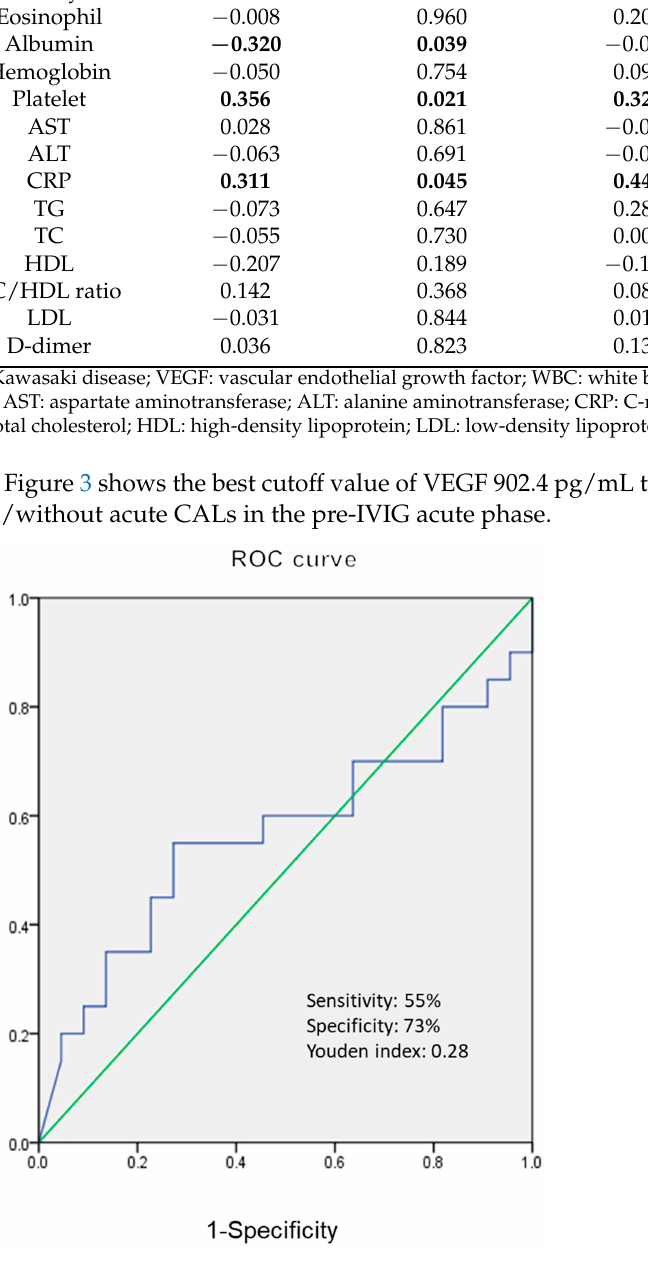
Figure 3. ROC curve for differentiating KD patients with/without acute CALs in the pre-IVIG acute phase at the cutoff value of VEGF 902.4 pg/mL. Figure 4 shows the best cutoff value of VEGF 1106.7 pg/mL to differentiate KD pa- tients with/without acute CALs in the post-IVIG acute phase.